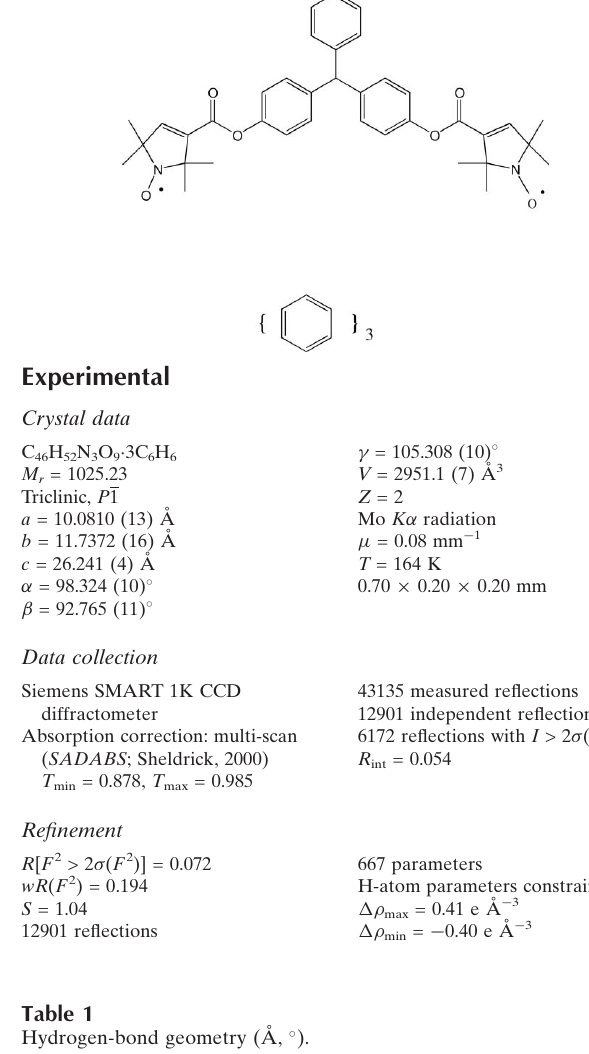
Hydrogen-bond geometry (A˚ , (cid:3)